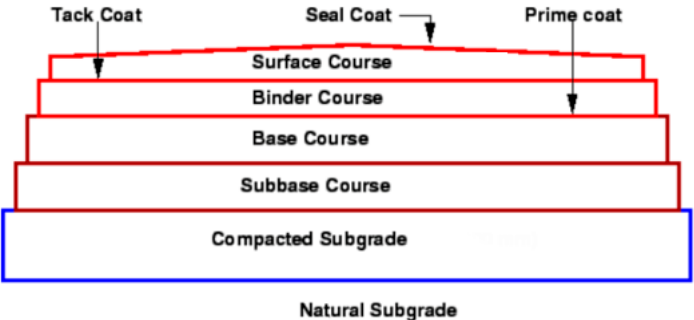
Figure 2. A typical road cross section that shows its various layers.